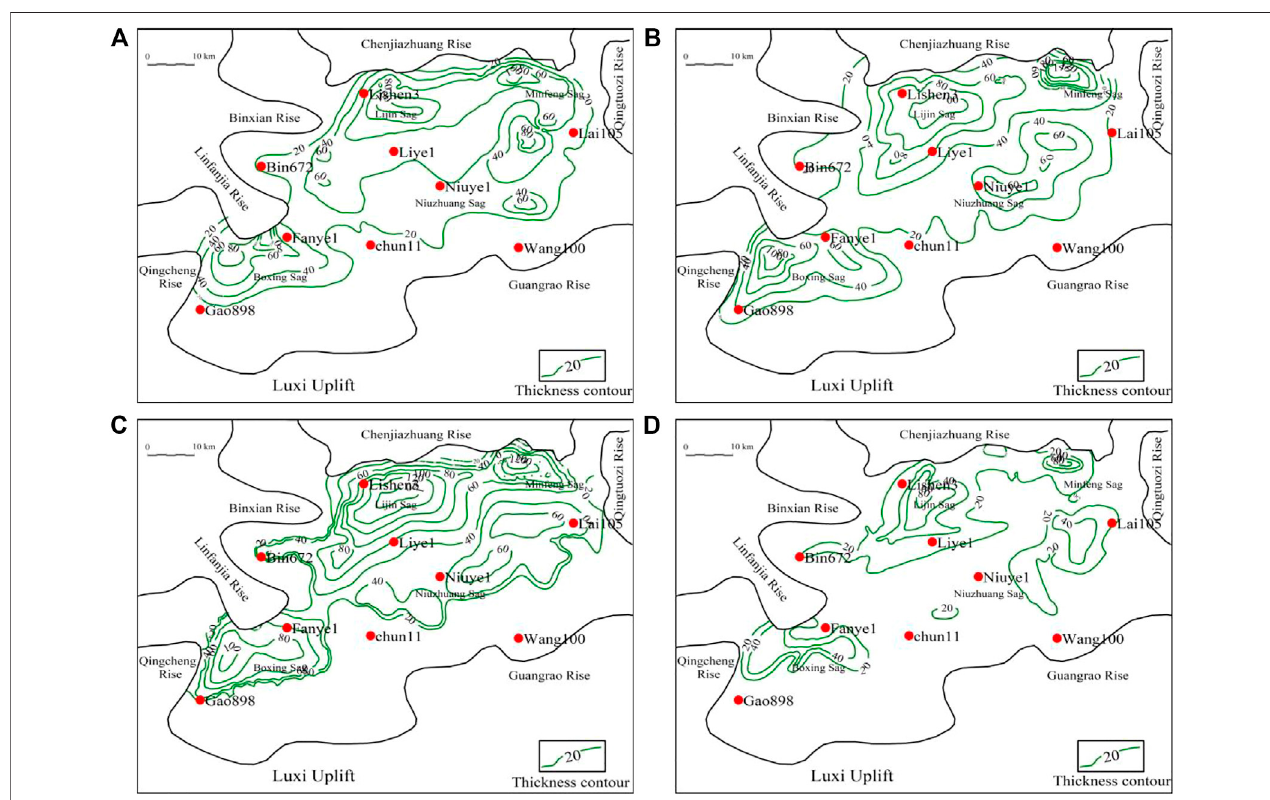
FIGURE 4 | Thickness contour map of each sub layer in Es3x (A) : fi rst sub layer; (B) : second sub layer; (C) : third sub layer; (D) : fourth sub layer).